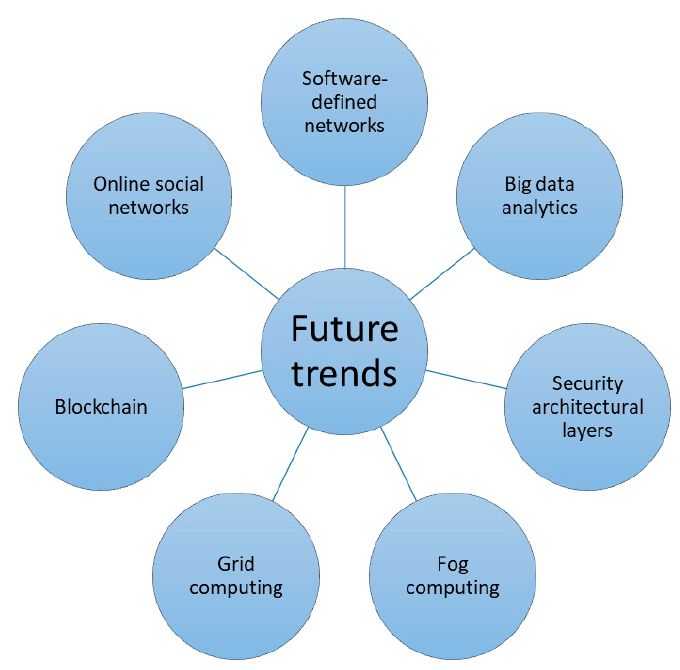
Figure 12. Future trends in clinical laboratory systems within IoT ecosystems.